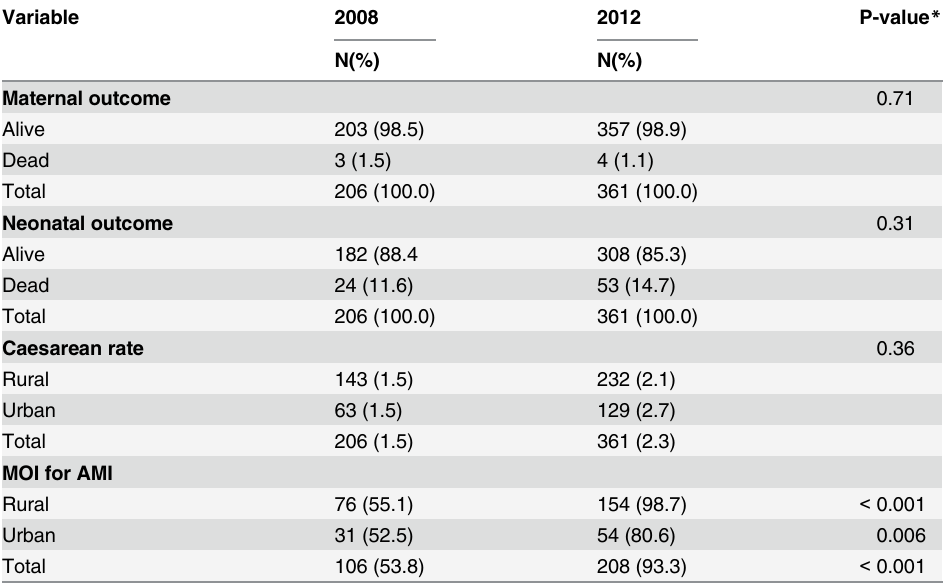
Table 2. Maternal and child outcomes before and after the adoption of the policy at Kissidougou Dis- trict Hospital in 2008 and